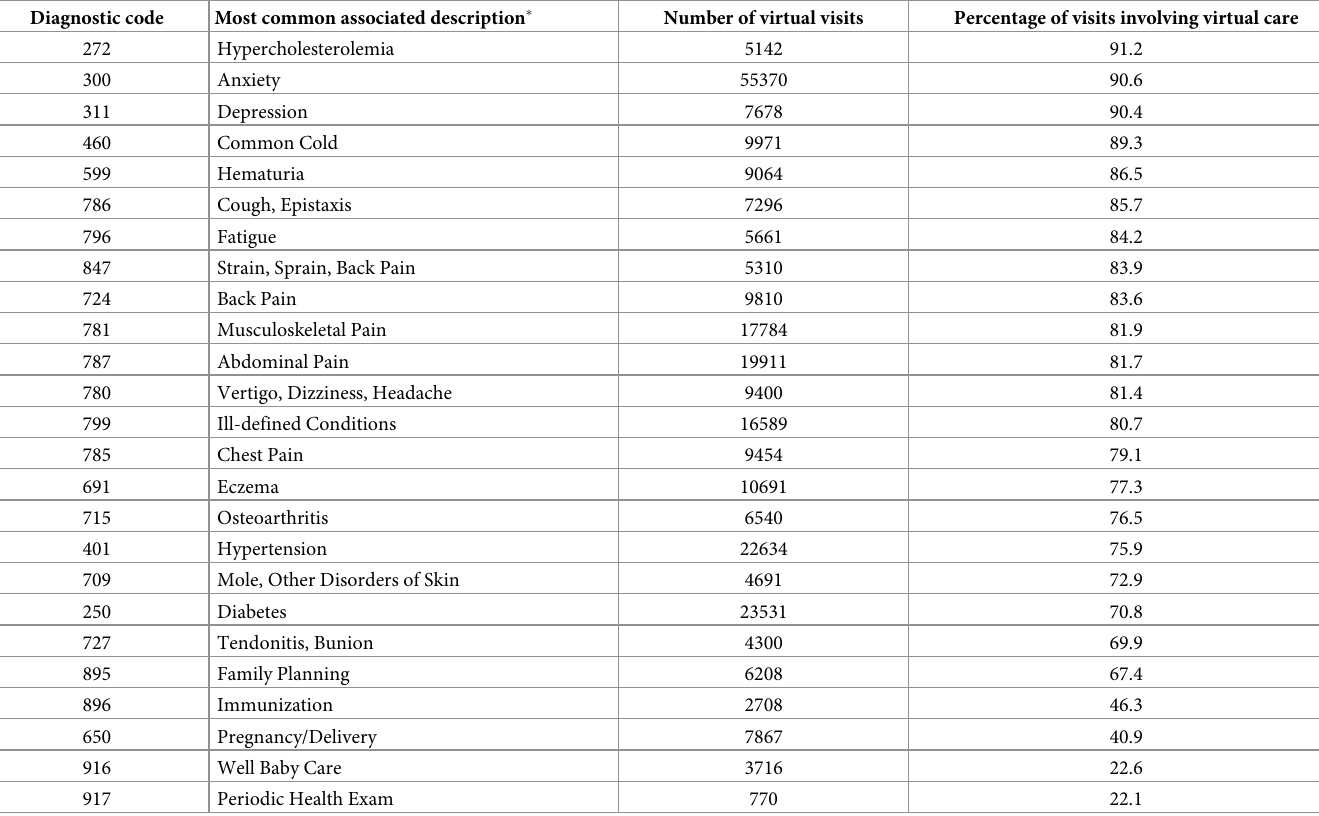
Table 4. Rate of virtual visits during the COVID-19 pandemic for the most common diagnoses. Diagnostic